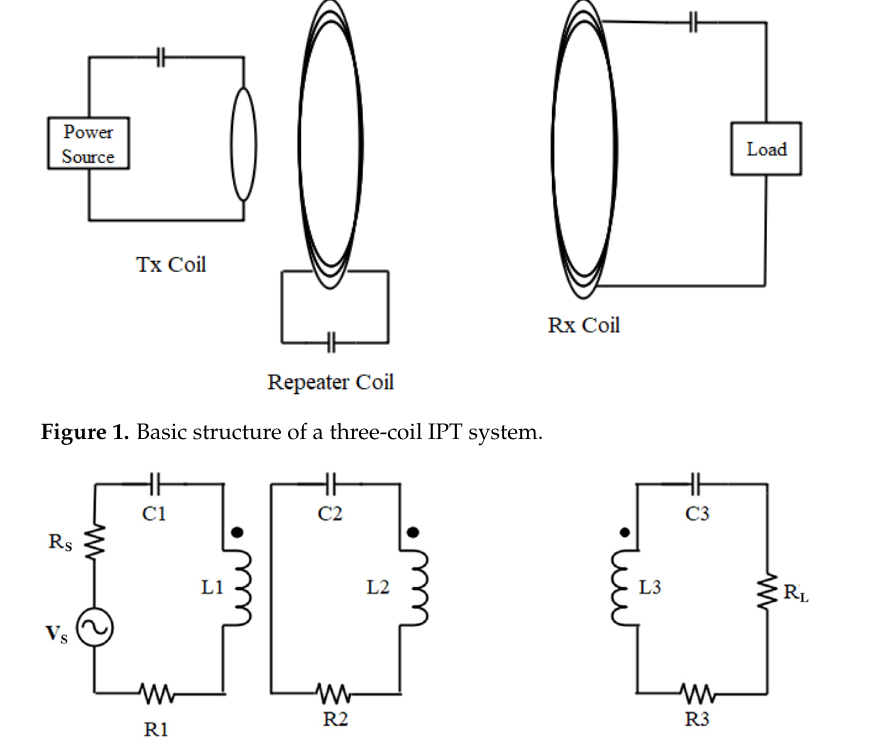
Figure 2. Circuit model of a three-coil IPT system.